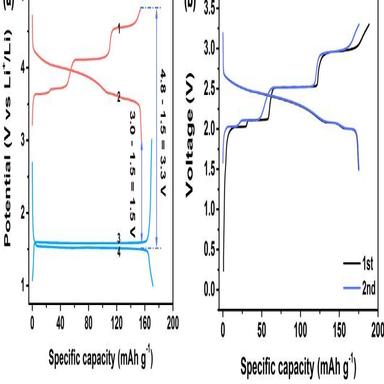
(a) Voltage matching principle and (b) discharge/charge profiles for the LTO||LVP battery.